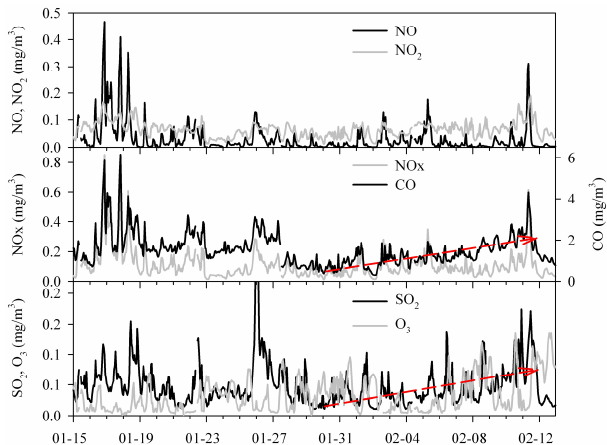
Fig. 2. Time series of hourly NO x (NO + NO 2 ), CO, SO 2 and O 3 Fig. 2. Time-series of hourly NOx (NO + NO 2 ), CO, SO 2 and O 3 concentrations. The dashed concentrations. The dashed arrow lines denote the trends of CO and arrow lines denote the trends of CO and SO 2 concentrations during the post-holiday pollution SO 2 concentrations during the post-holiday pollution episode from 31 January to 11